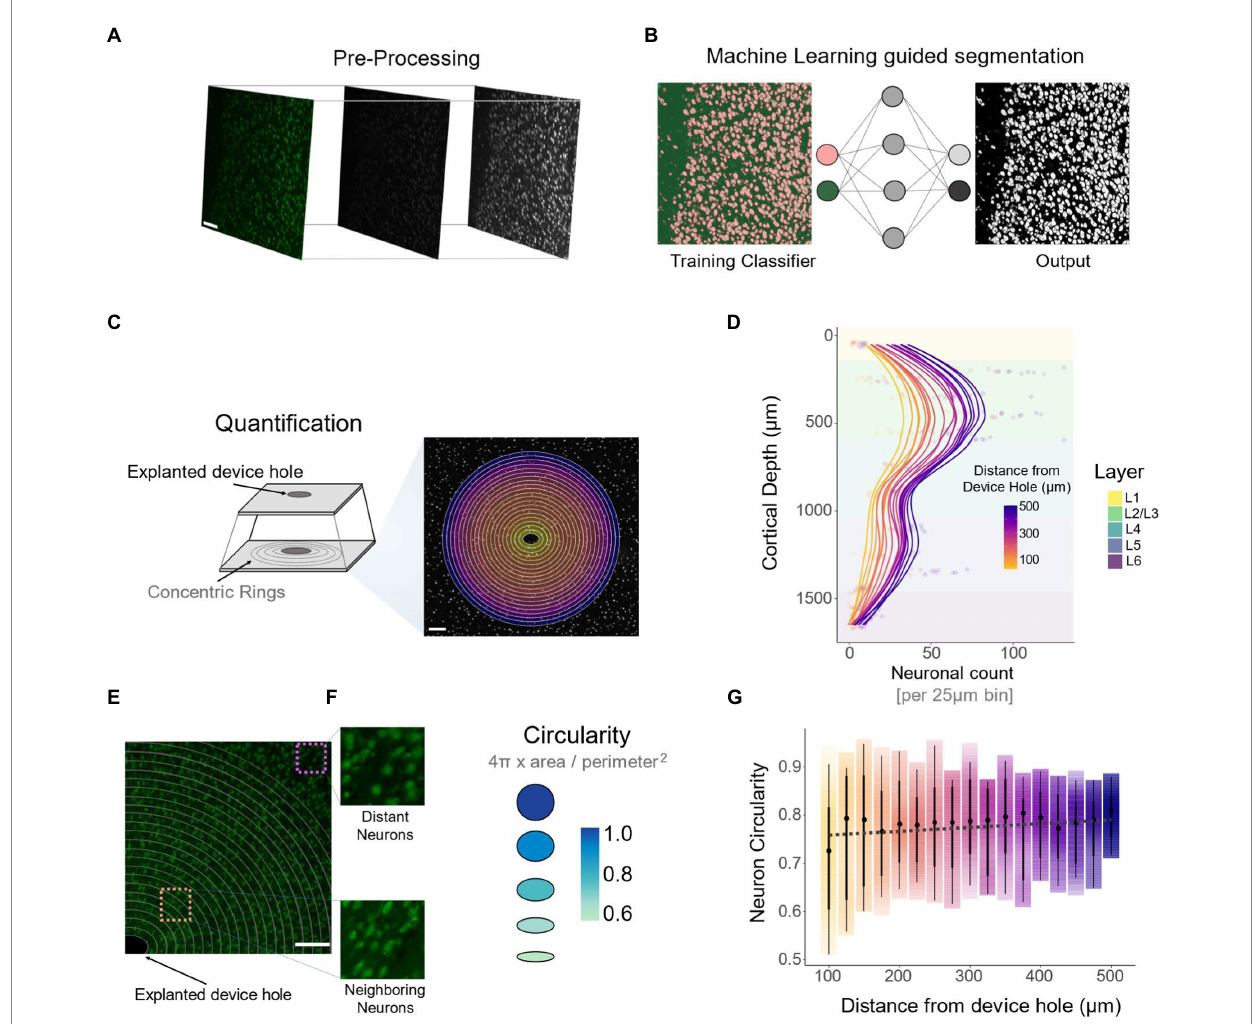
FIGURE 8 Quantification of neuronal density across cortical depth and cellular morphology via DeepHisto Machine learning segmentation. (A) Pre-processing pipeline consisting of 8-bit conversion followed by a Gaussian blur and contrast enhancement. (B) A multilayer perceptron machine learning classifier was trained to classify background pixels from individual neurons. (C) Following scaling, 25 μ m isometric concentric rings were drawn around the device hole. (D) Number of individual neuronal nuclei per 25 μ m bin across cortical depth ( N = 5). (E) Representative image of morphological differences of neurons neighboring the electrode (bottom, orange square) compared to neurons away from the electrode (top purple square). (F) To assess morphological differences in neurons surrounding the device, circularity was computed. (G) Quantification of neuronal circularity and distance from the device hole. Black dots represent the median and thick lines represent 95% confidence intervals. The opacity of the color gradient represents data density. All scale bars are 100 μ